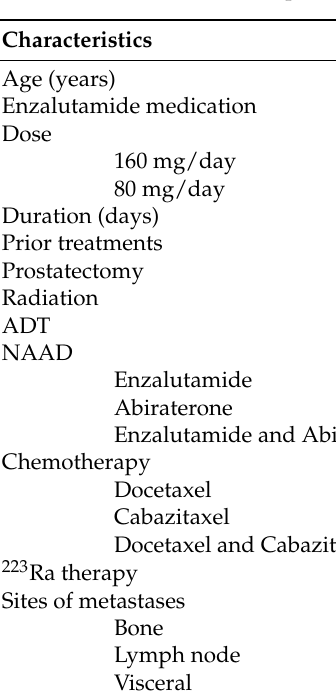
Table 1. Characteristics of the patient